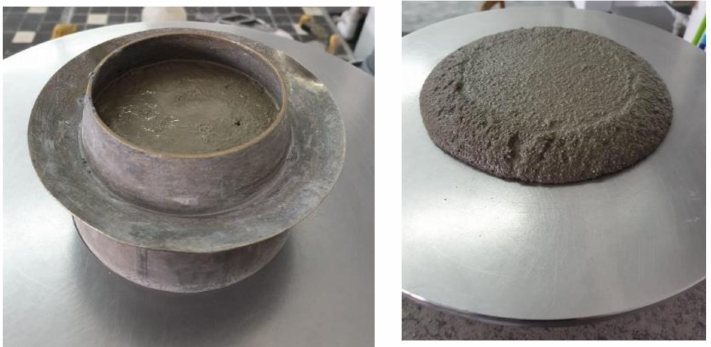
Figure 8. The flow of fresh mortar with the addition of 30% of MSWI slag after shaking 15 times (authors’ photo).